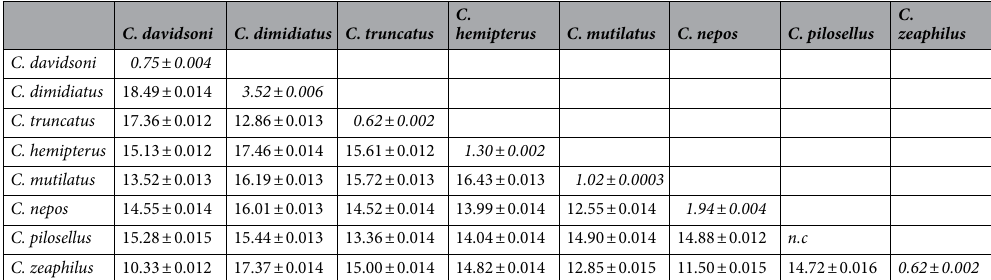
Table 2. Uncorrected p -distance values based on COI barcoding portion of Carpophilus spp. Interspecific distances (± SE) are below diagonal, intraspecific distances (± SE) are in italic along the diagonal. n.c.: not calculable.